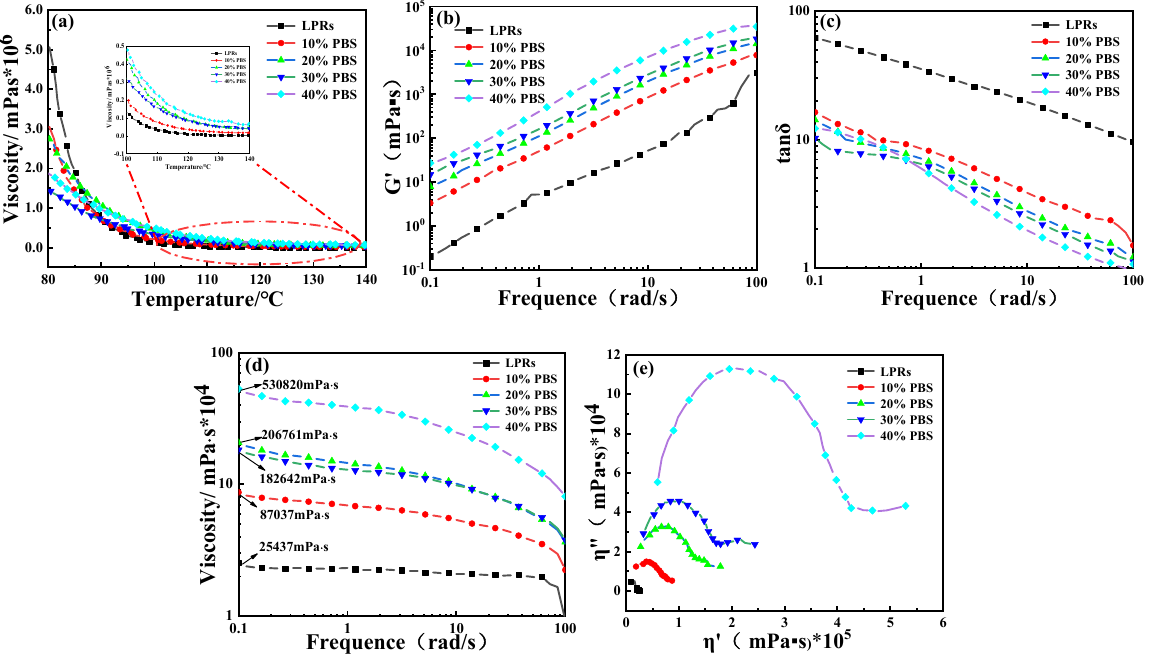
Figure 6. ( a ) Plots of viscosity versus temperature; ( b ) plots of G’ versus frequency; ( c ) plots of loss factor versus frequency; ( d ) dynamic viscosity curves; and ( e ) Cole–Cole plots of virtual viscosity ( η″ ) versus real viscosity ( η ’).